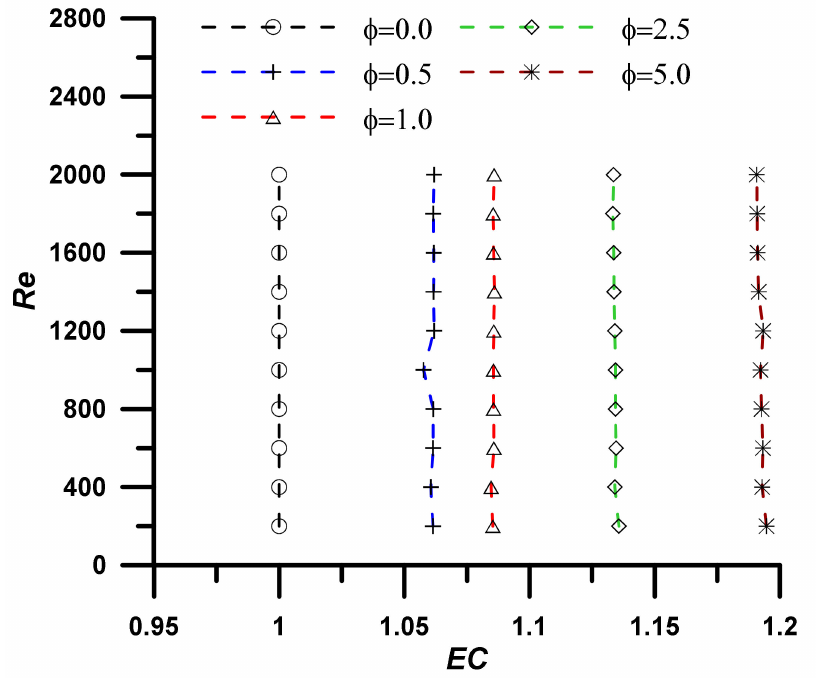
Figure 8. Evaluation performance criteria at T = 333.15 K for investigated nanoparticle